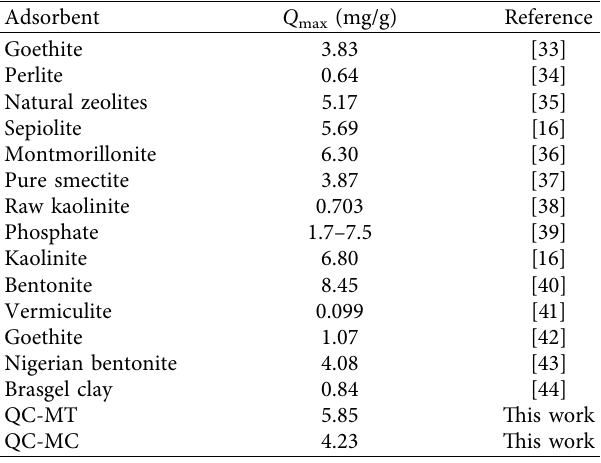
Table 5: Comparison of adsorption capacities of Cd (II) on various